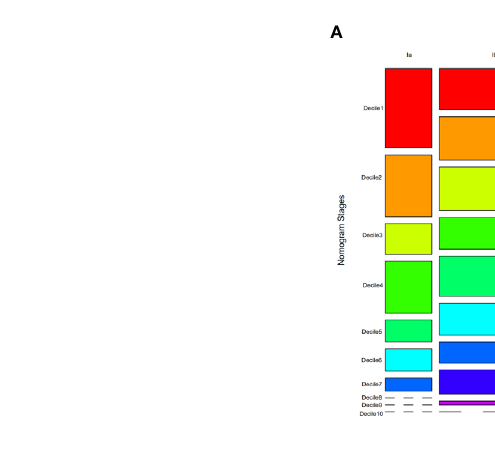
FIGURE 7 | Mosaic plots using the training cohort. (A) Mosaic plots for PHC and (B) PBTC in which each of the 10 deciles was represented by 1 of 10 consecutive rainbow colors. The area of the individual mosaics represents the represents the proportions of corresponding patients. The short-segmented lines indicate a frequency of zero.